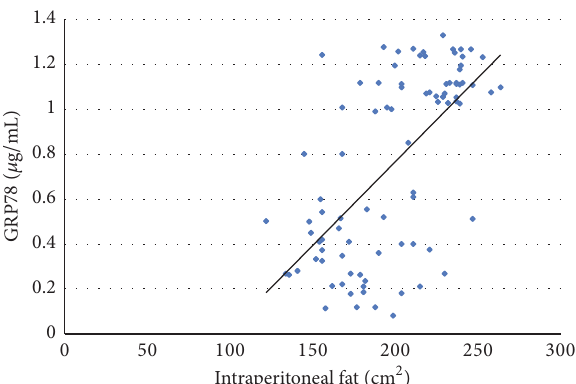
Figure 2: Correlation between GRP78 and intraperitoneal fat.